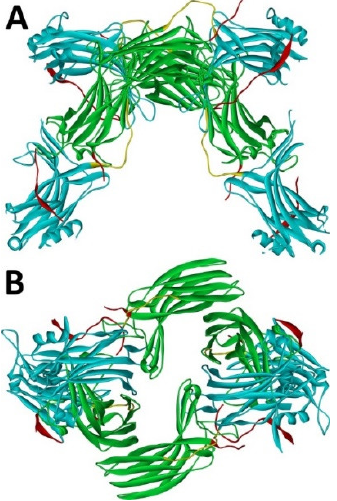
Figure 1. Crystal tetramer of bovine arrestin-1. ( A ), side view. ( B ), top view. PDB ID 1CF1 [24]. In each protomer arrestin-1 elements are colored, as follows: N-domain (residues 1–178), blue; inter- domain hinge (residues 179–190), yellow; C-domain (residues 191–356), green; C-tail (from residue 357; the gap reflects that part of the C-tail are invisible in crystal), red. Images were created in DS ViewerPro 6.0 (Dassault Systèmes, San Diego, CA, USA).